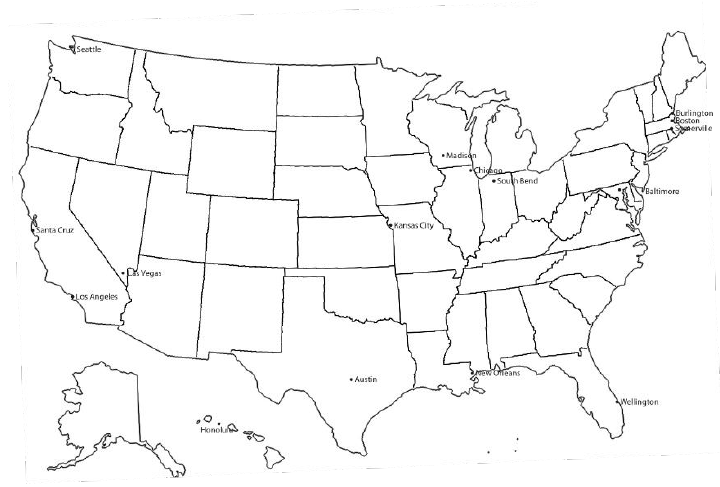
Table 2: The 16 OGD Cities: Basic Details